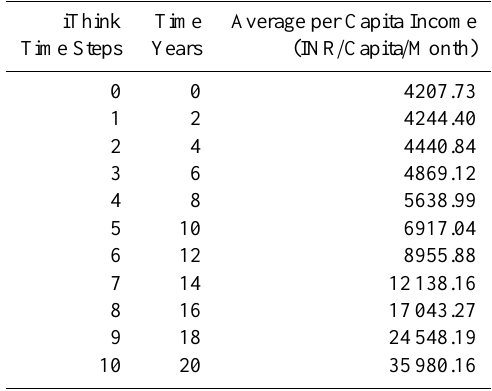
Table 10. iThink model results.